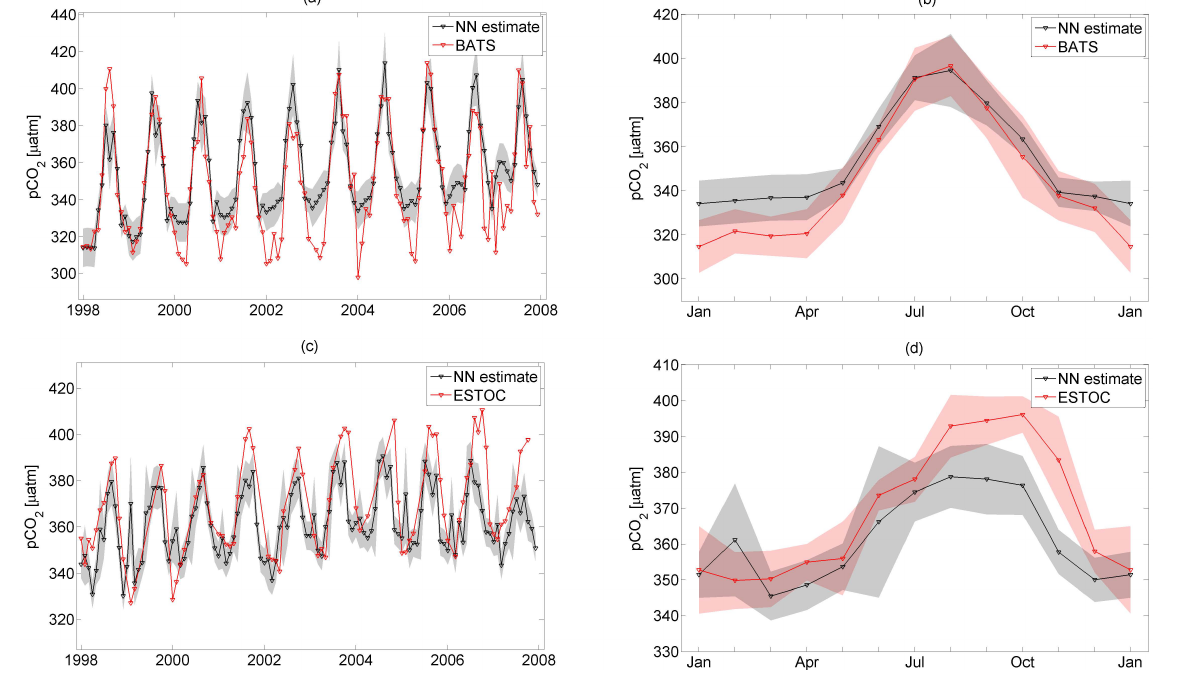
Fig. 4. Validation of neural network results with p CO 2 (a, b) from the BATS Hydrostation “S” (Bates, 2007; Gruber et al., 2002) and (c, d) from the ESTOC (González-Dávila et al., 2007) time-series stations. In (a) and (c) the actual time-series data are compared, while in (b) and (d) , the long-term mean seasonal cycle is evaluated. Grey shading shows the uncertainty of the neural network estimate based on its RMSE. Red shading shows the standard deviation of the mean seasonal cycle for each time-series